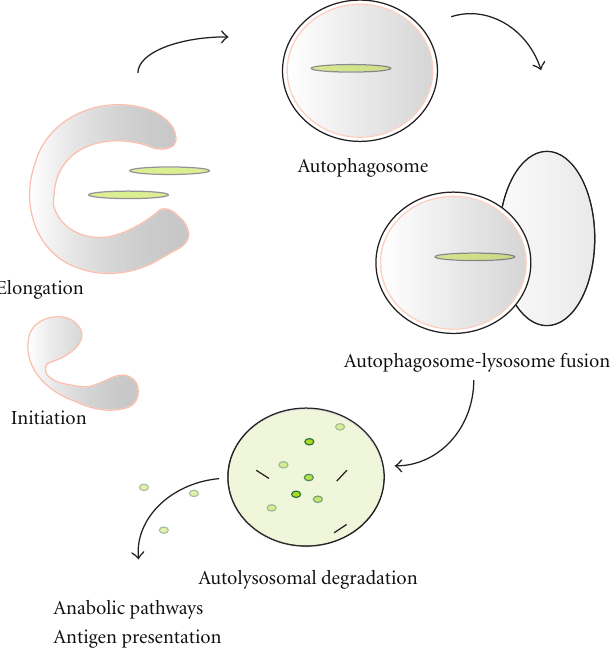
Figure 1: The “macroautophagic” pathway responds to stimulationby various environmental cues including nutrient availability or noxious agents, which result in the accumulation of damaged proteins and/or organelles as well as pathogenic bacteria or viral infection. In the nucleation phase, a preautophagosomal structure develops from subcellular membranes and subsequently evolves into the phagophore or isolation membrane. The isolation membrane then expands to surround and engulf a cytoplasmic “cargo” of material targeted for degradation, culminating in double-membraned autophagosomes. Finally, the fusion of autophagosomes with lysosomes results in the formation of the autolysosome. During the degradative phase of autophagy, the encapsulated contents of autolysosomes are digested by lysosomal degradative enzymes (e.g., cathepsins and other acid hydrolases). The digested contents are then released to the cytosol for reutilization in anabolic